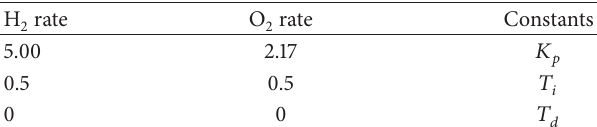
Table 3: Controller parameters for oxygen and hydrogen rate